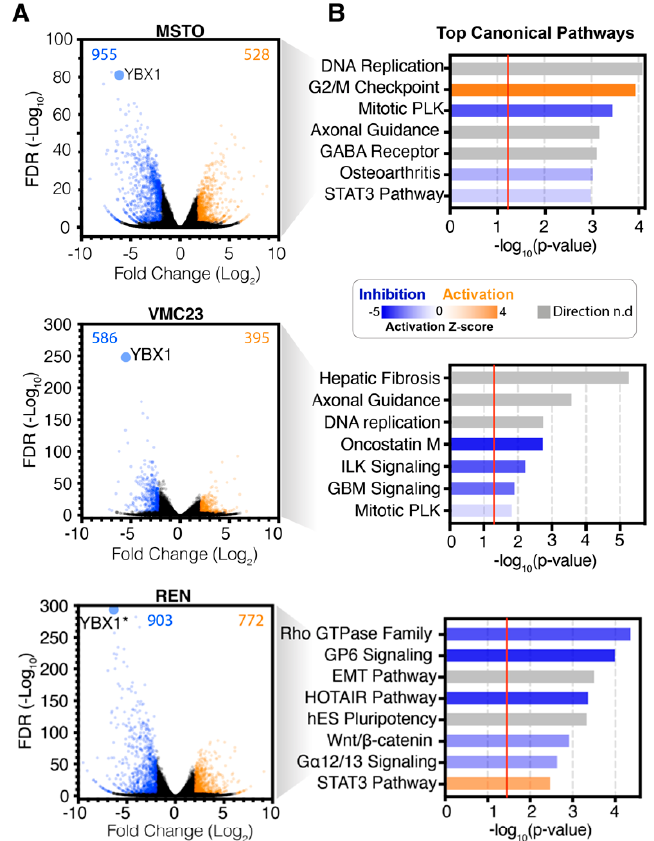
Figure 2. RNA-seq analysis identifies that proliferation-related pathways are altered in MPM cells after YB-1 siRNA transfection. ( A ) Volcano plots displaying significantly downregulated (blue) or upregulated (orange) genes after YB-1 knockdown. Significance cut-offs were defined as log 2 (fold change) < − 2 and > 2, q -value (FDR) < 0.001. ( B ) IPA canonical pathway analysis of the RNA-seq data. Predictions of inhibition (blue) or activation (orange) or no change (white) states are based on the Ingenuity ® Knowledge Base, which compares the expected change with experimental observation to all known upstream regulators. Variable stringent p -value ( > 1.3) and z-score ( > 0.5) cut-offs were used to limit pathways to top 7–8 most significant hits. Grey bars indicate where no directionality could be determined (Direction n.d).